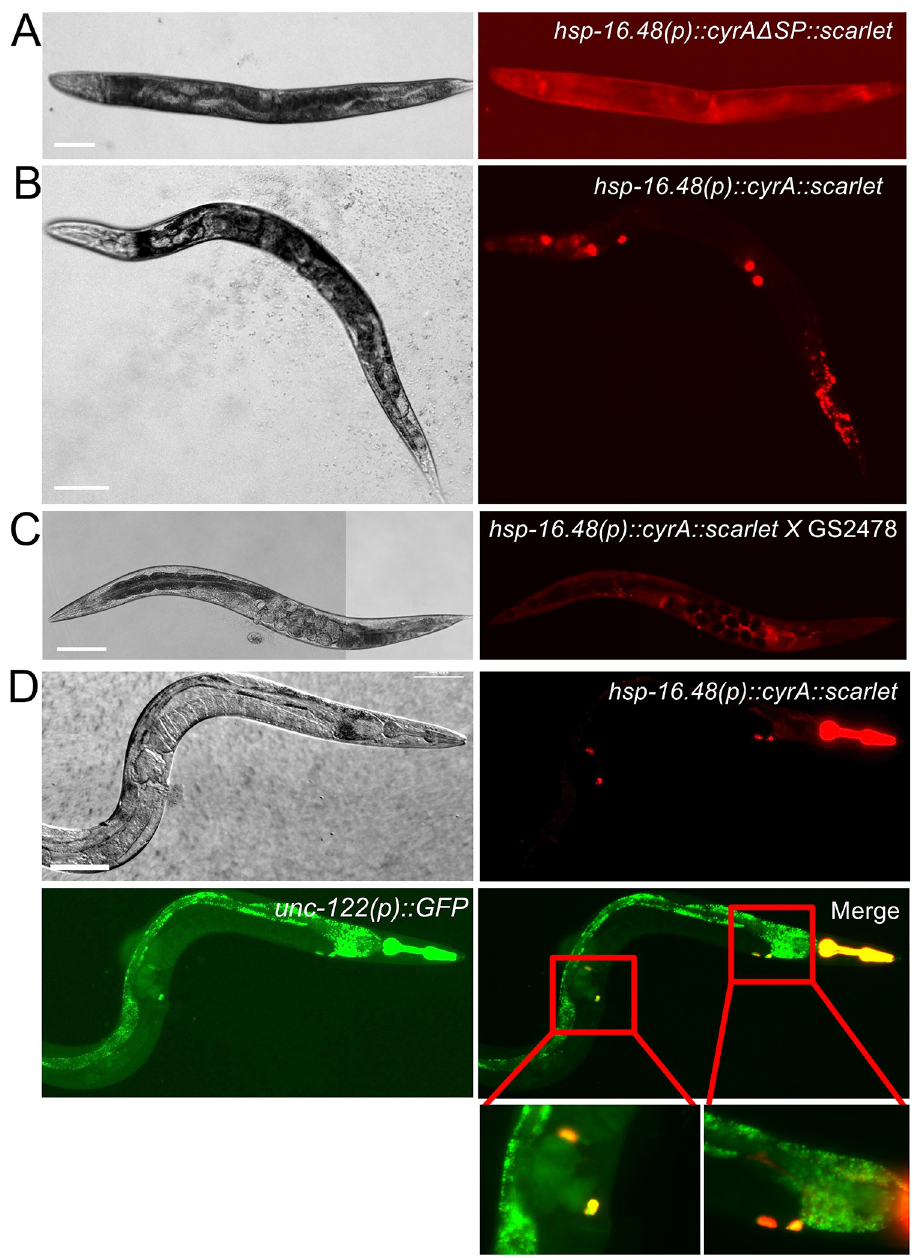
Fig 7. CyrA accumulates in coelomocytes in C . elegans . The cyrA gene fused to scarlet was expressed with ( A, C, strain KIT02) and without ( B , strain KIT04) its signal peptide sequence under the heat inducible promoter hsp-16 . 48 . Expression was induced by heat shock at 37˚C for 1 hour. (C) CyrA-Scarlet expressed with SP in the coelomocyte uptake deficient C . elegans strain GS2478 (strain KIT26). Scale bars = 100 μ m. (D) CyrA-Scarlet was co-expressed with the coelomocyte marker unc-122(p) :: GFP . Co-localization is shown in the